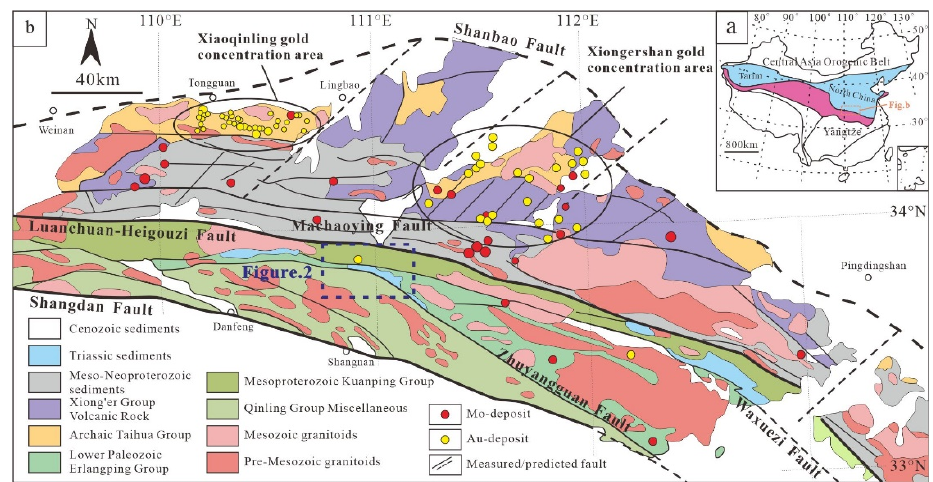
These applications have achieved a series of good results.